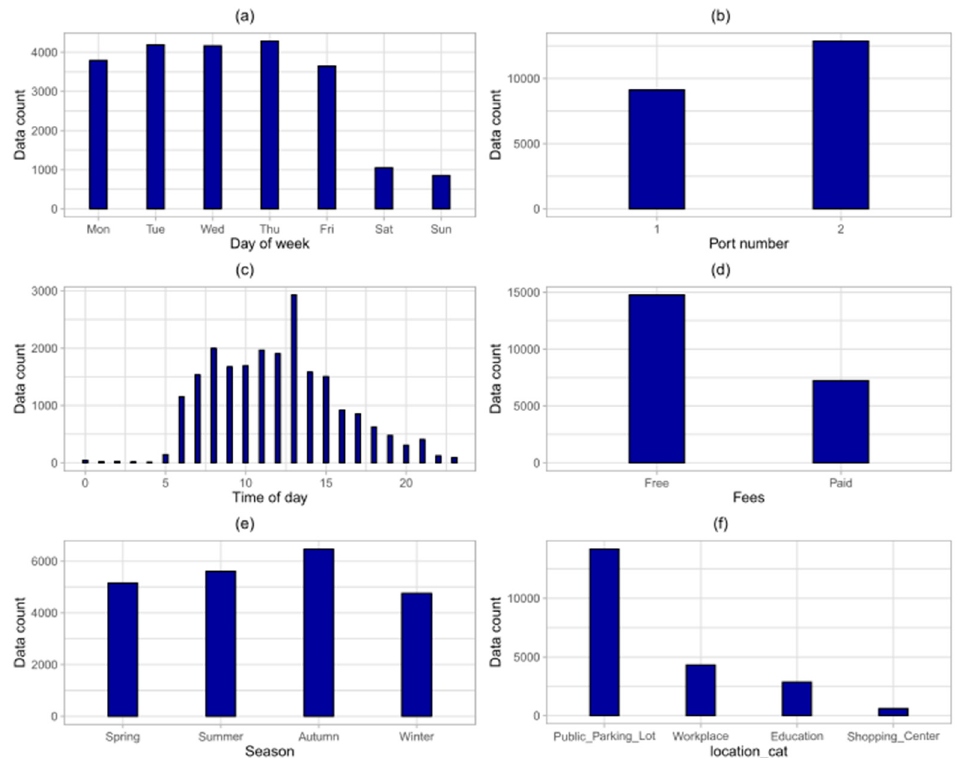
Figure 4. Histogram of sessions by ( a ) Day of Week, ( b ) Port Number, ( c ) Time of Day, ( d ) Fees Policy, ( e ) Seasons, and ( f ) Location category.